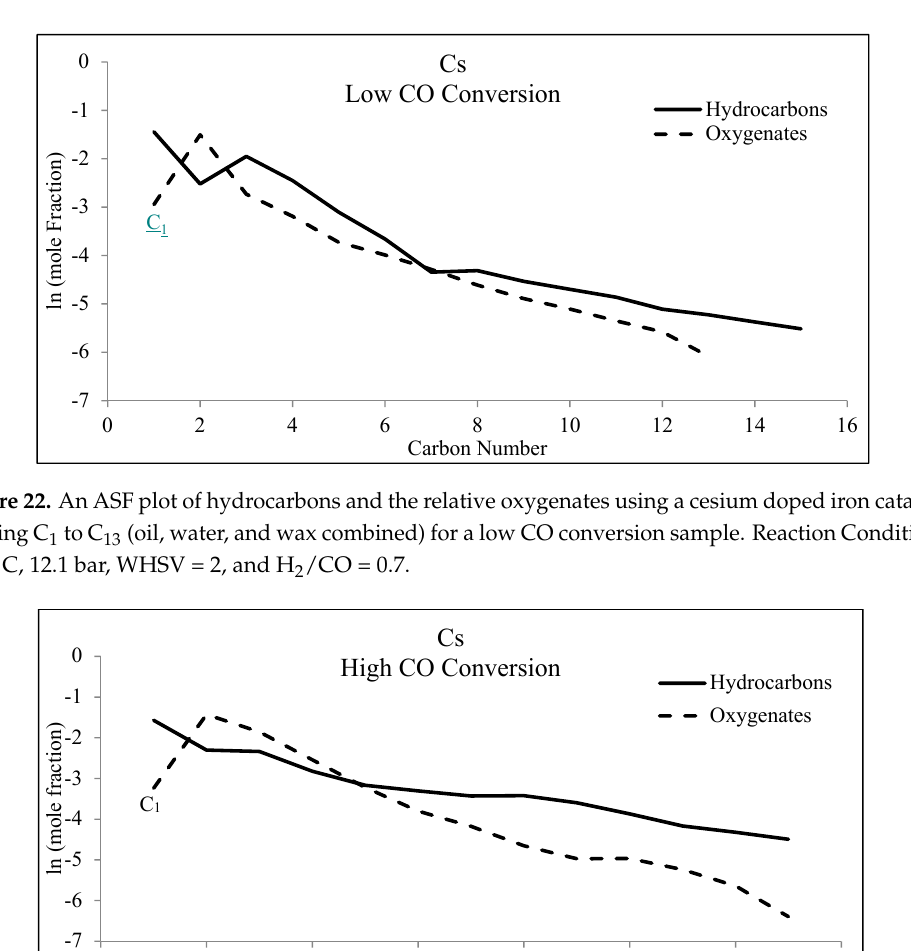
Figure 23. An ASF plot of hydrocarbons and the relative oxygenates using a cesium doped iron catalyst, ranging C 1 to C 14 (oil, water, and wax combined) for a high CO conversion sample. Reaction Conditions: 270 °C, 12.1 bar, WHSV = 2, and H 2 /CO = 0.7.